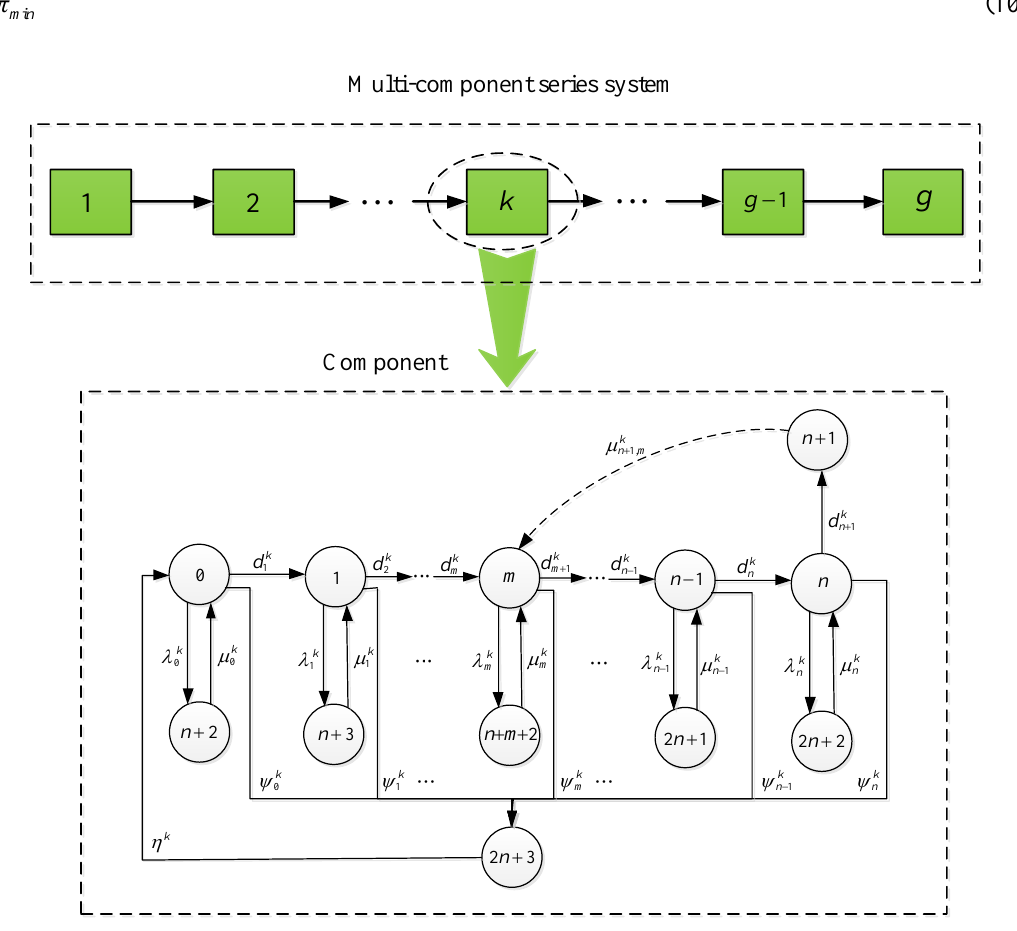
Figure 6. Multi-state series